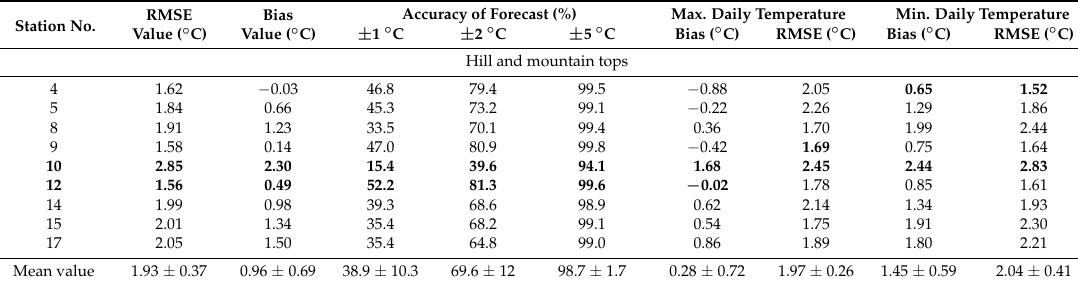
Table 9. Verification of air temperature forecast for the period 1 January to 30 April 2018. Station